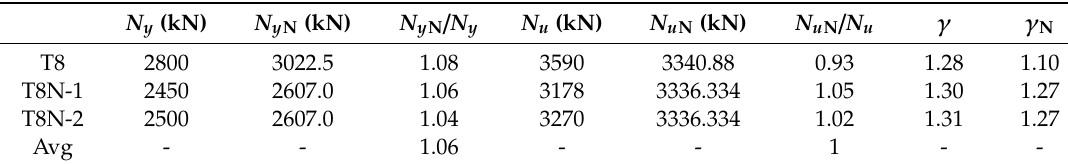
Figure 13. Comparisons of load-displacement curves: ( a ) specimen T8 and ( b ) specimen T8N. Table 6. Comparison of experimental and analytical results.